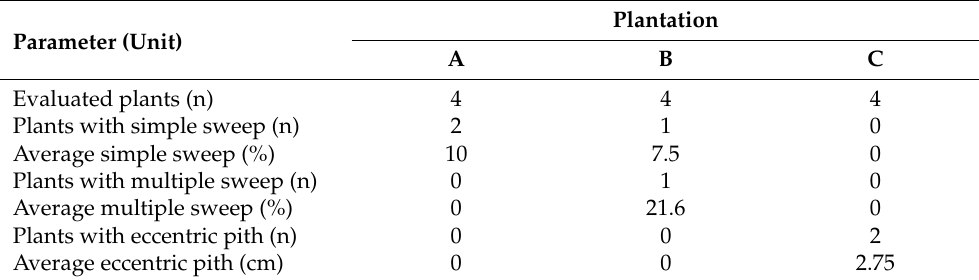
Table 4. Paulownia roundwood characteristics measured at plantations A, B, and